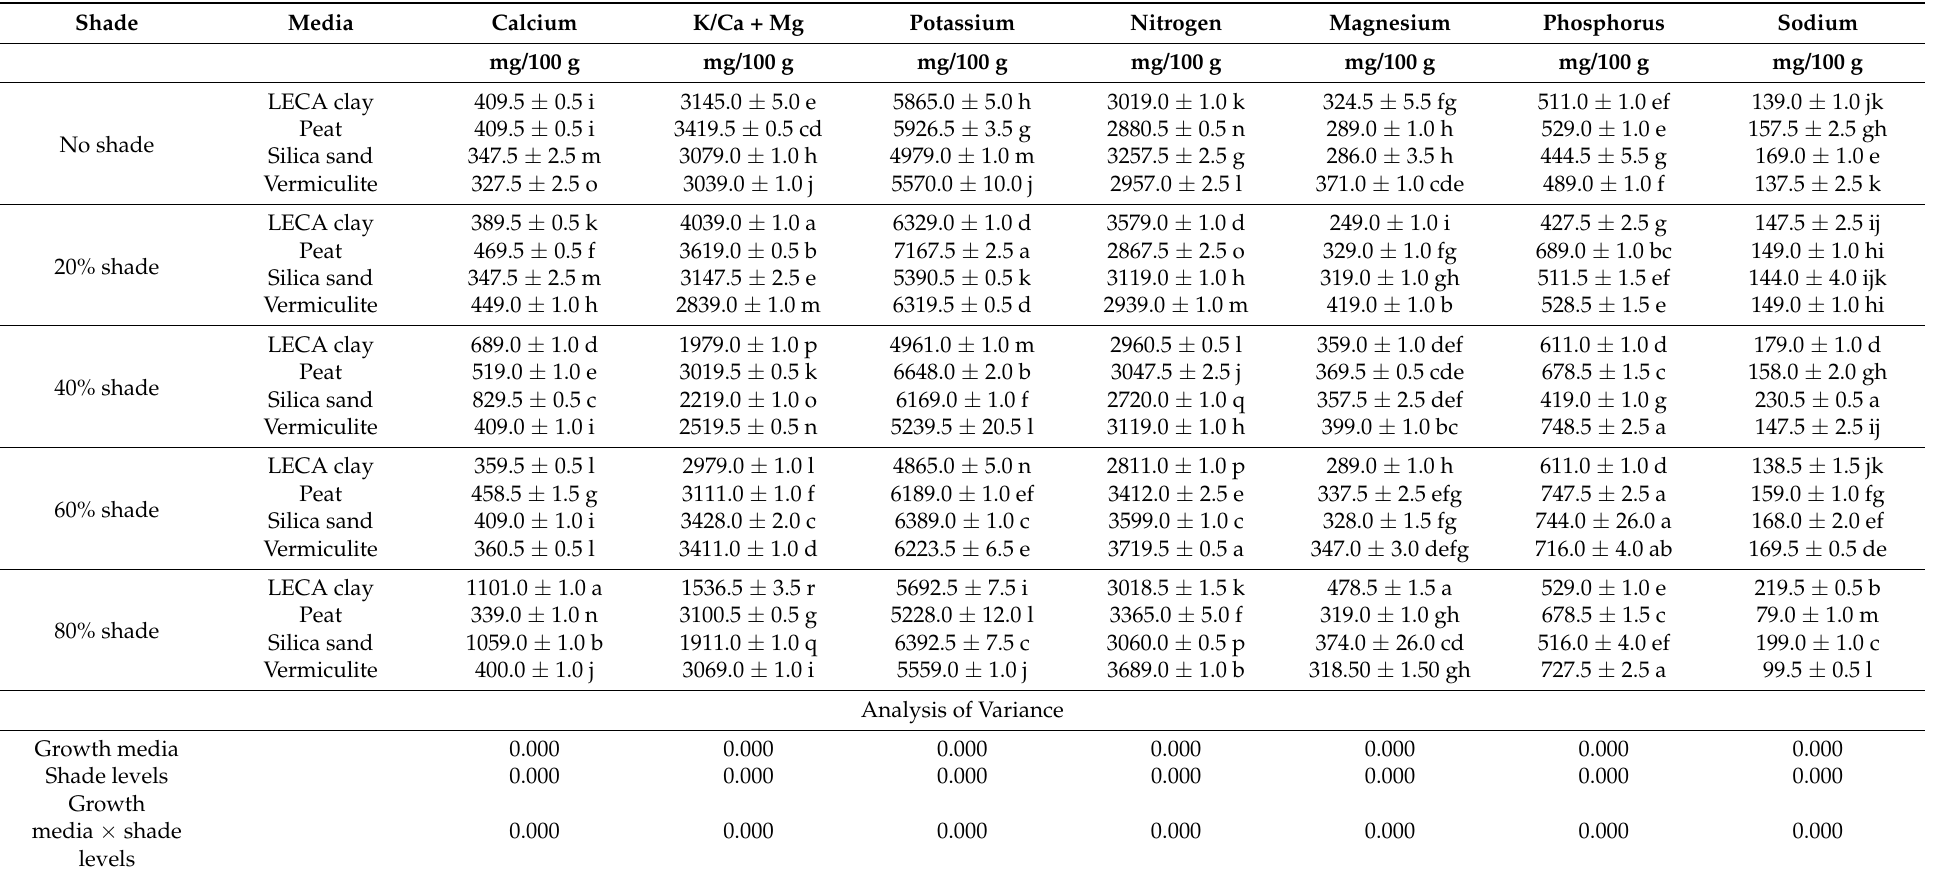
Table 3. The effect of different growth media and shade levels on macronutrient content in the flower buds of T. divaricata